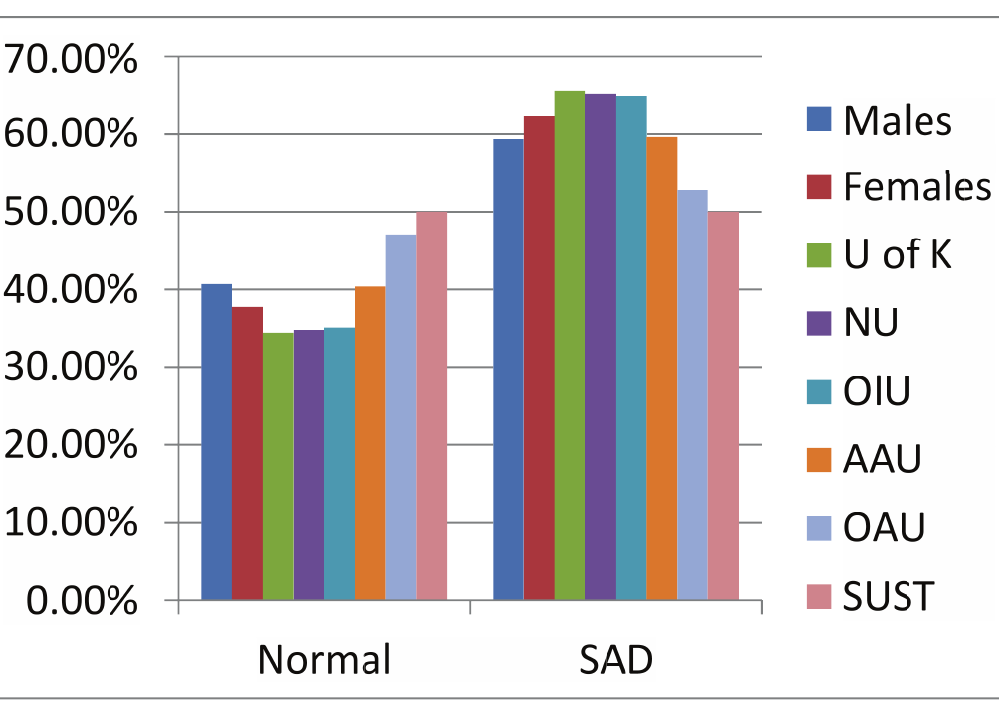
Figure 2 : Prevalence of SAD by gender and university.